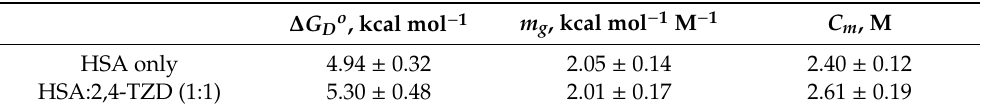
Table 6. Thermodynamic parameters associated with the GdmCl-induced denaturation of HSA in the presence or absence of 2,4-TZD at pH 7.4 and 25 ◦ C. Values are means of triplicates ±